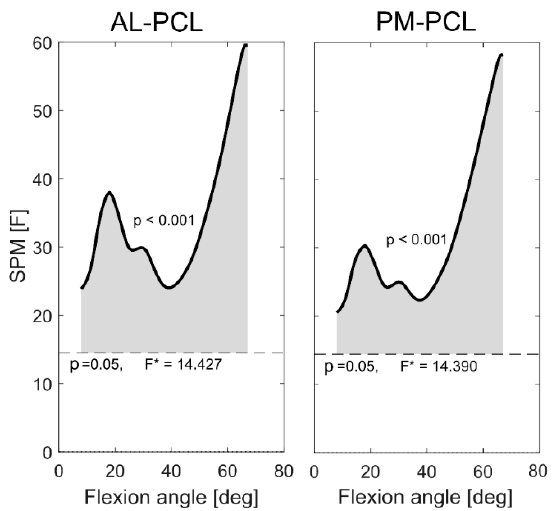
Figure 4. Statistical parametric mapping (SPM) plots show significantly different PCL elongation patterns between the stance and swing phases of stair descent in subjects with posterior cruciate retaining total knee arthroplasty (PCR-TKA).